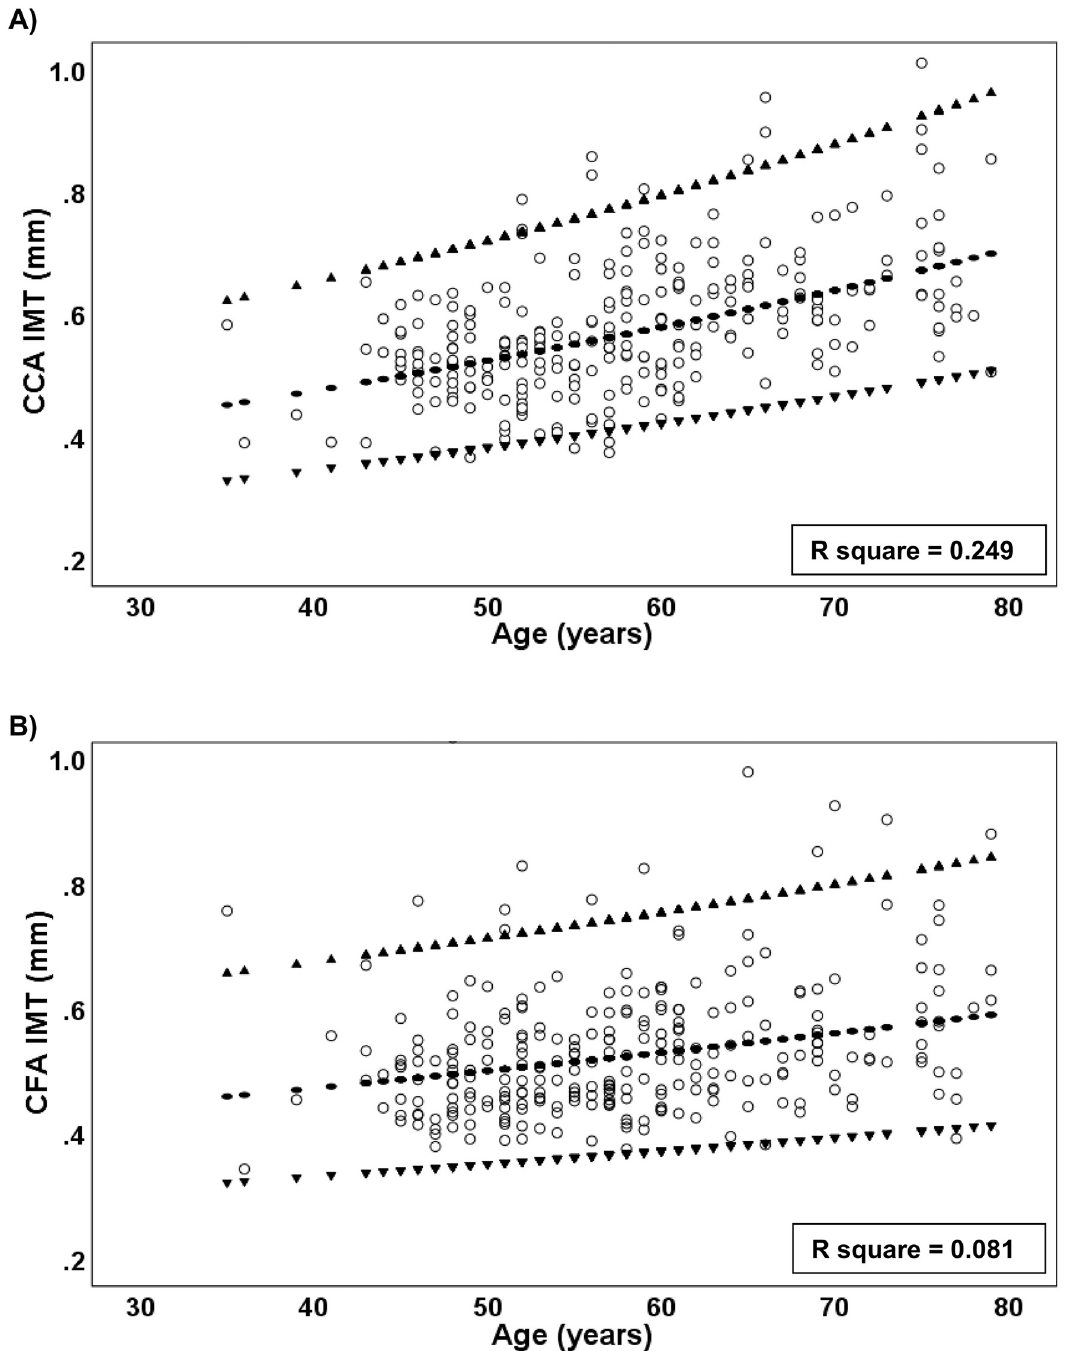
Fig 2. Main group IMT-age relationships. Scatter plots of IMT versus age for CCA (A) and CFA (B). The back-transformed predicted values and 95% confidence bands from the linear regression of ln(IMT) on age are shown. R 2 for the relationship is higher for the CCA than for the CFA, but both have wide predictive bands for IMT indicating significant non-age-related variability.